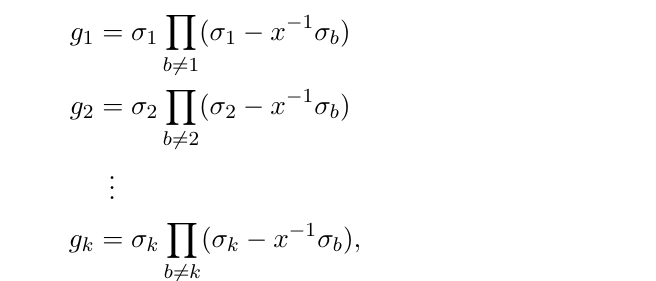
Figure 2 . Excitations of half-BPS giant graviton branes dual to det X